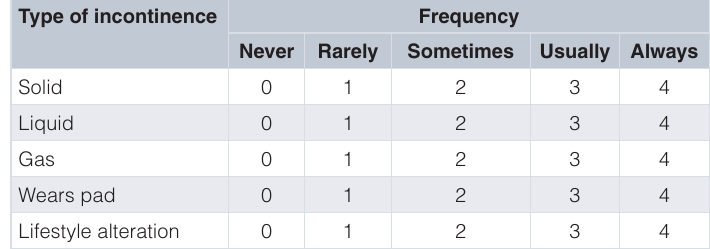
Table 1. Cleveland Clinic Florida-Fecal Incontinence Score.